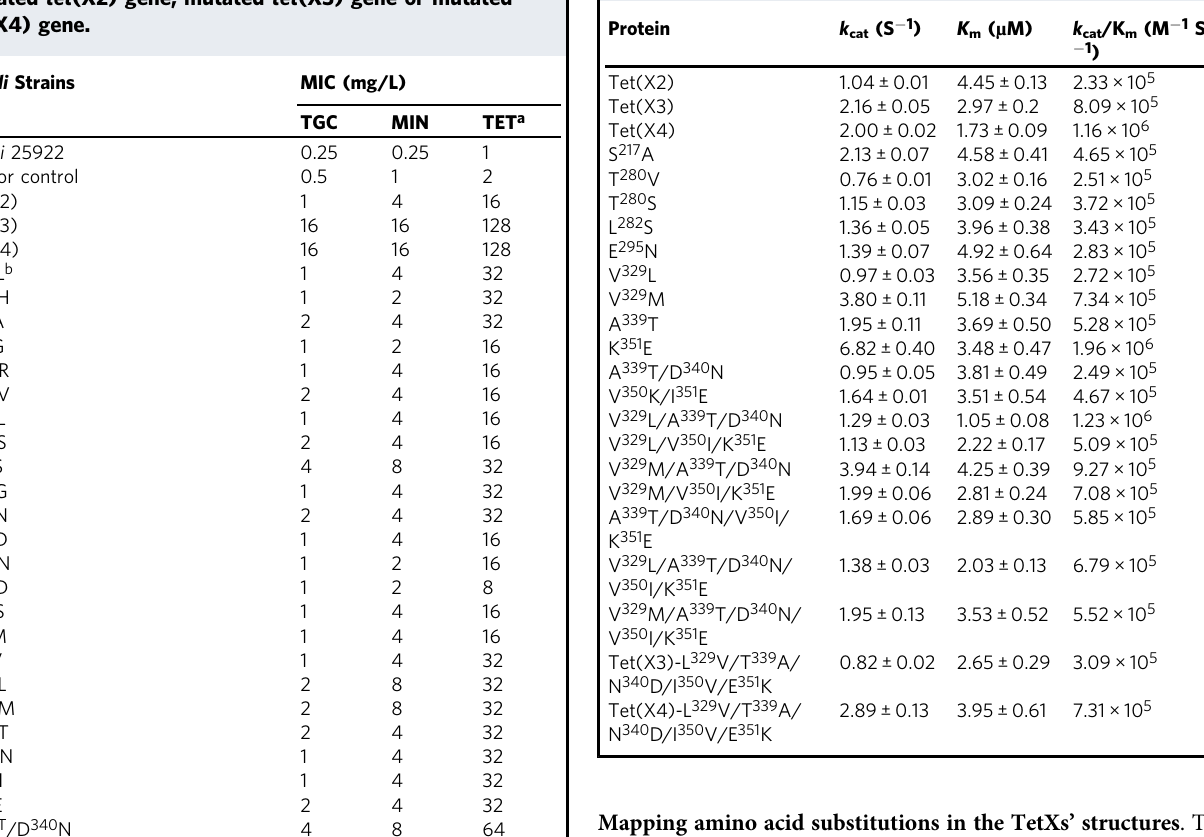
Table 2 Kinetic parameters (± SD) of the TetX proteins on